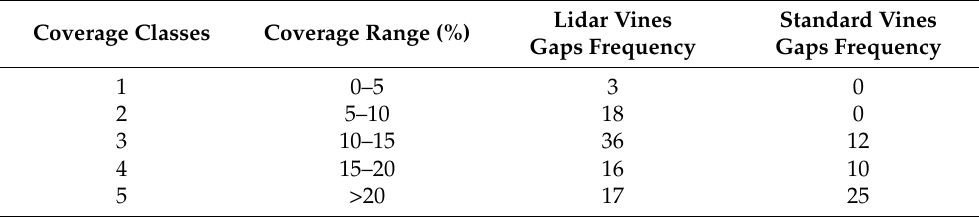
Table 5. Summary table of the LiDAR and standard WSP samples placed in vine gaps.